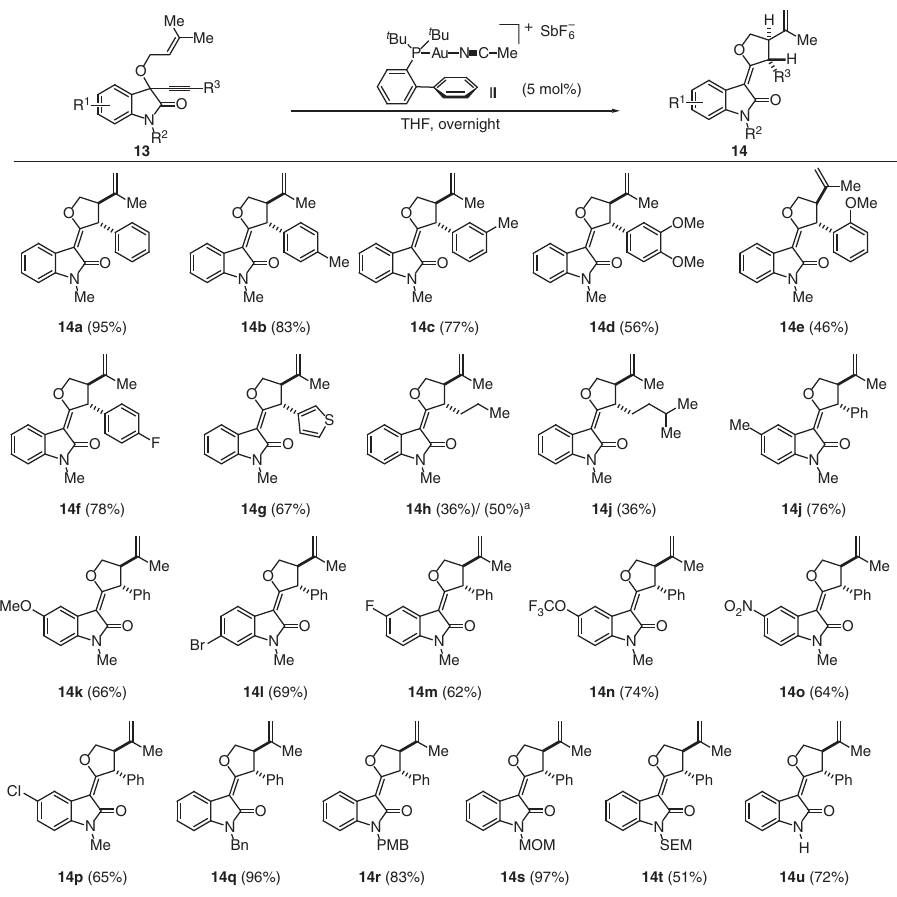
Figure 4 | Scope of the gold catalysed rearrangement of O -prenylated substrate 13 to df -oxindoles 14. Reaction condition: 1,6-enynes 13 (0.1M), II (0.5mol%), THF, 0 (cid:2) C to rt, overnight. MOM, methoxymethyl; SEM, (2-(trimethylsilyl)ethoxy)methyl; THF,